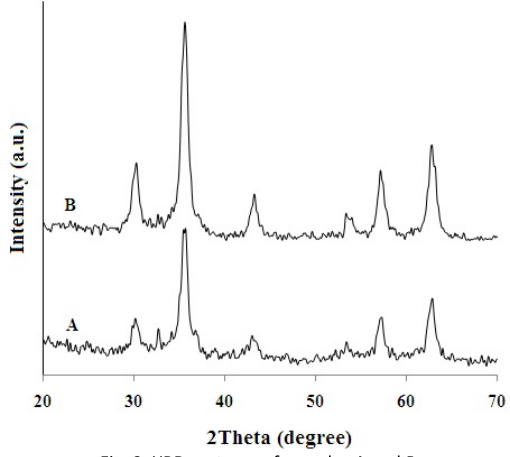
Fig. 3. XRD patterns of samples A and B